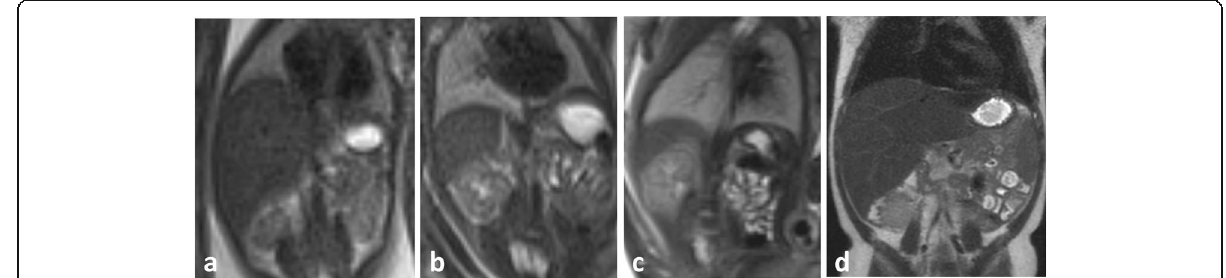
Fig. 2 Selected images of coronal T2-weighted MRI showing the appearance of normal diaphragm (arrows) at 21, 29, and 33 weeks of gestation and in a newborn ( a , b , c and d